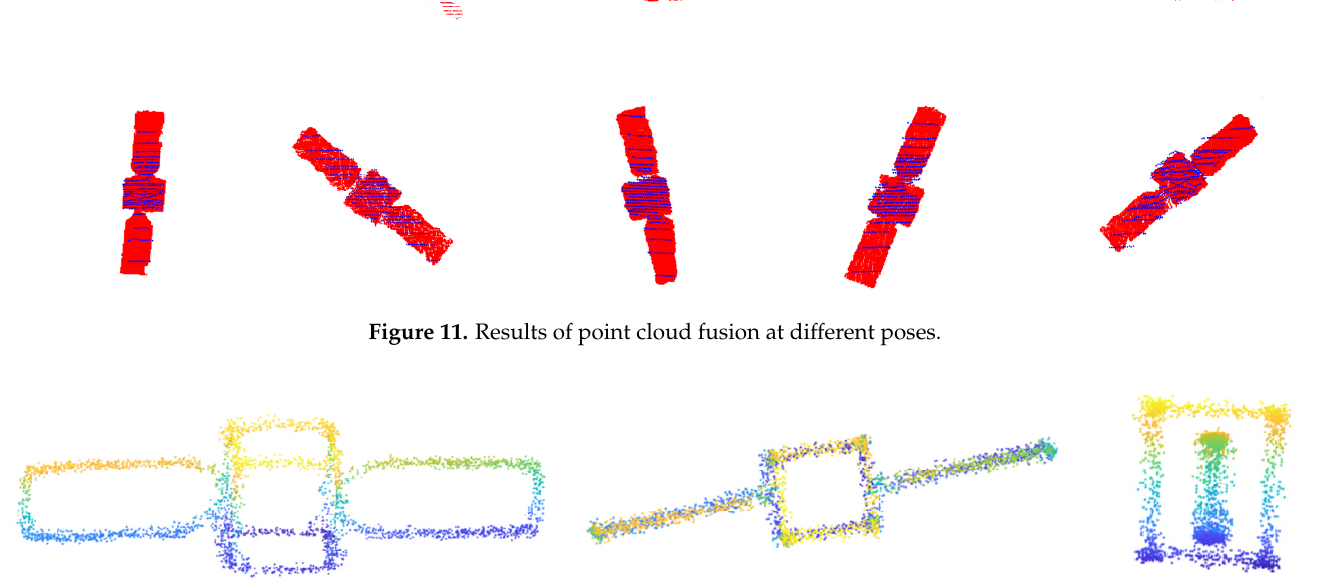
Figure 12. Contour model of the target spacecraft.